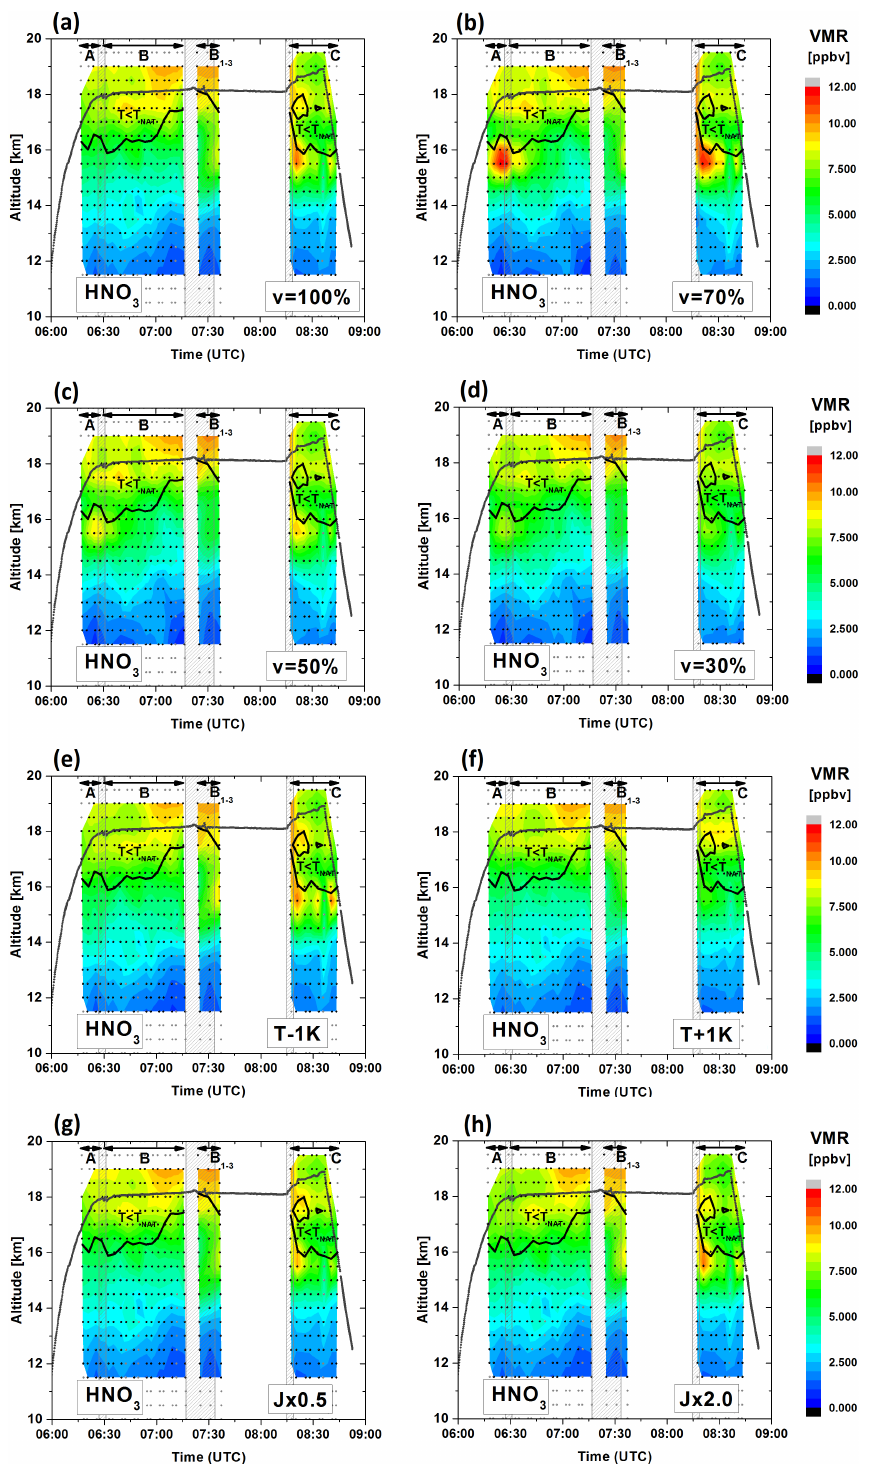
Figure 9. Vertical cross sections of gas-phase HNO 3 extracted from the CLaMS reference simulation ( v = 100%), scenarios considering reduced settling velocities of NAT particles ( v = 70%, v = 50% and v = 30%), temperature biases of ± 1K ( T − 1K and T + 1K) and modified nucleation rates (J × 0.5 and J × 2.0) for the PSC flight on 25 January 2010. Other parameters (including T NAT line) as in Fig.